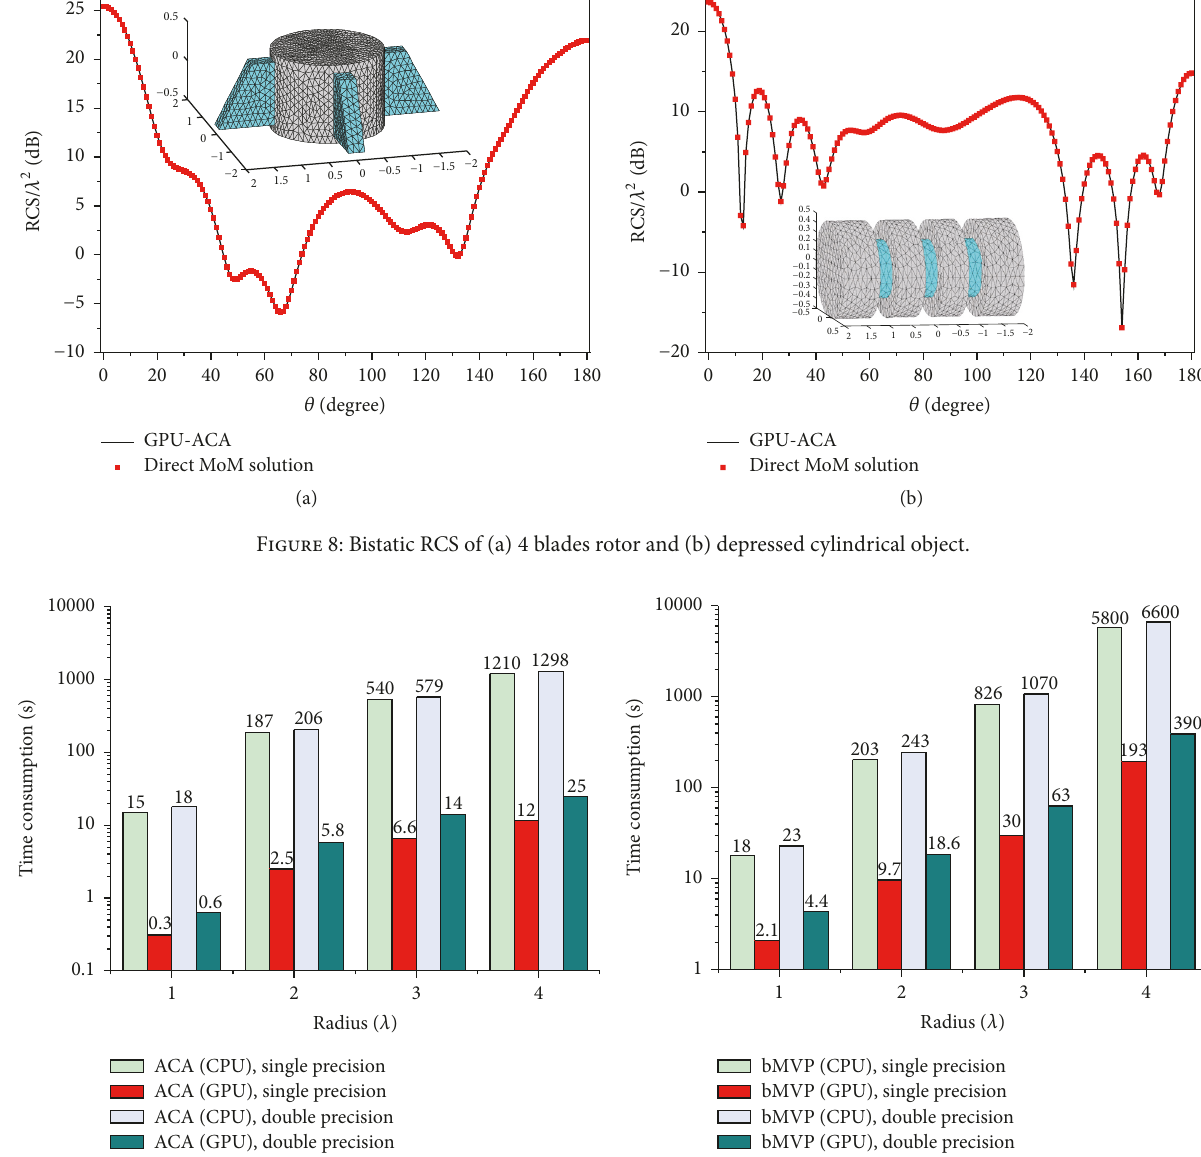
Figure 9: Efficiency comparison of (a) ACA and (b) bMVP.